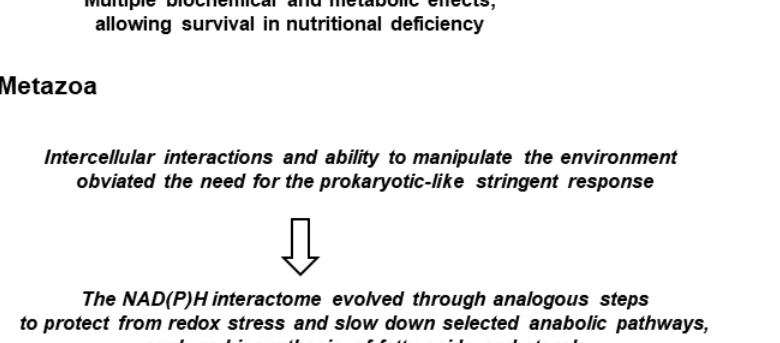
Figure 8. Tentative theory of evolution of the stringent response in prokaryotes ( A ) and the very different response in metazoa, dubbed ‘stringent-like response’ (Section 4) ( B ). This is only a schematic of the biochemical pathways that have been described in this review, integrated with possible steps of evolutionary expansion of the interactome (hereby named ‘stringentome’). In Panel A, we propose four alternative arrangements (1–4) of (p)ppGpp- and GTP-binding pockets in a proximal signaling protein of the interactome, as depicted schematically.